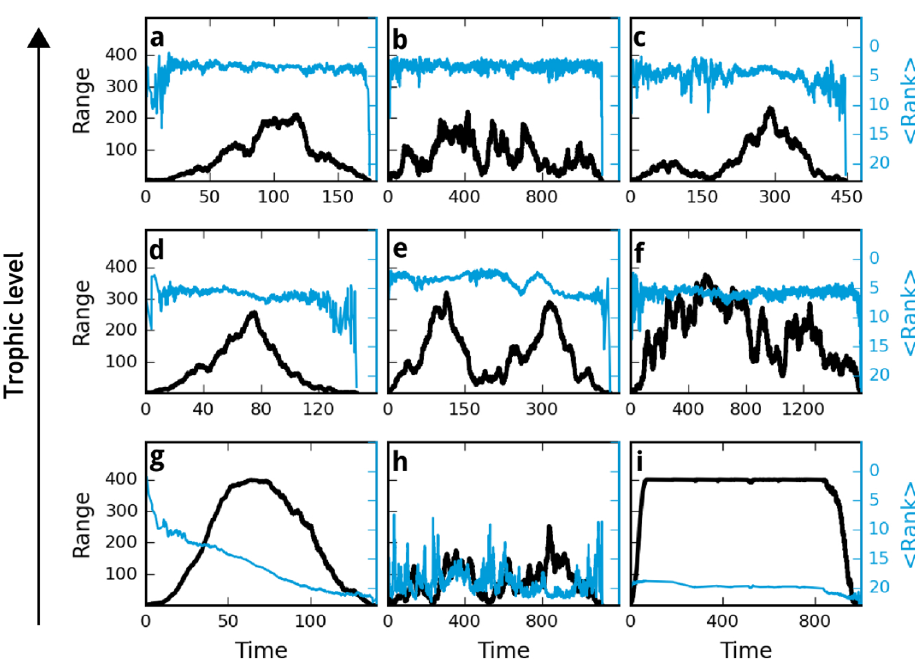
Figure 5. Collection of time evolution examples for range (black) and abundance-based rank (blue) of exemplary species from different trophic levels. Simulation set up was 400 habitats and a dispersal rate of 10. ( a – c ) Trophic level ≥ 3, ( d – f ) trophic level 2, ( g – i ) trophic level 1. Range evolution shows a triangular shape in some cases, especially often in the basal layer, whilst other species have large fluctuations in their range and rank over